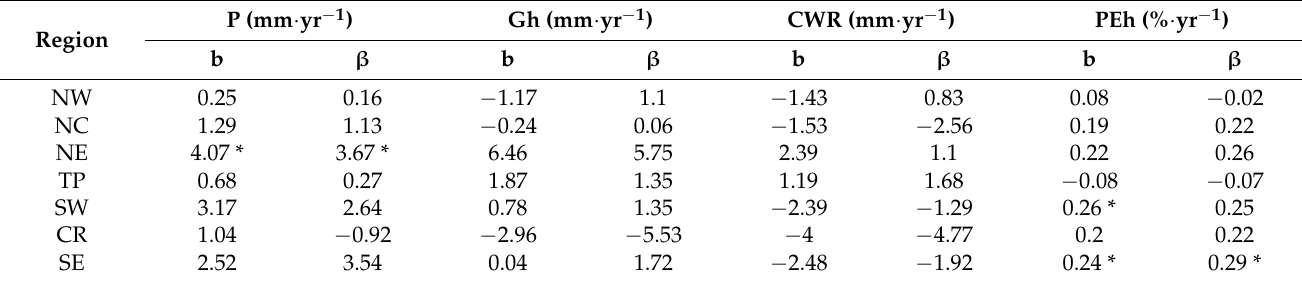
Table 1 quantifies the magnitude of the summer annual variations of CWR characteris- tic quantities in each region. The trend in a certain region was considered significant in this study when its confidence levels of both the least squares regression and the M–K test were greater than or equal to 95%. The trend was considered as being of little variation if the least squares trends were positive and M–K test trends were negative. P showed increasing trends in all regions except CR where there was little variation. Gh displayed increasing trends in the NE, TP, SW, and SE, a decreasing trend in CR, and little variation in the NW and NC. The increasing trends of CWR existed in the NE and TP, while decreasing trends were in NC, SW, CR, and SE, and little variation in the NW. For PEh, there were increasing trends in all regions except TP with a small decrease, and the NW with little variation. Table 1. Summer annual changing trends of P, Gh, CWR, and PEh in the seven sub-regions of China during the summers of 2001–2020. The b and β represent the least squares regression and M–K test trends, and the * indicates that the trends passed the significance test at the 95% confidence level.